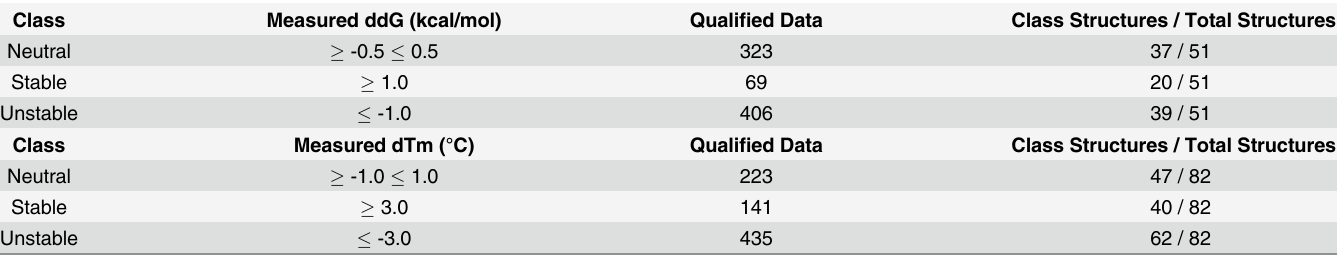
Table 1. Data set construction.